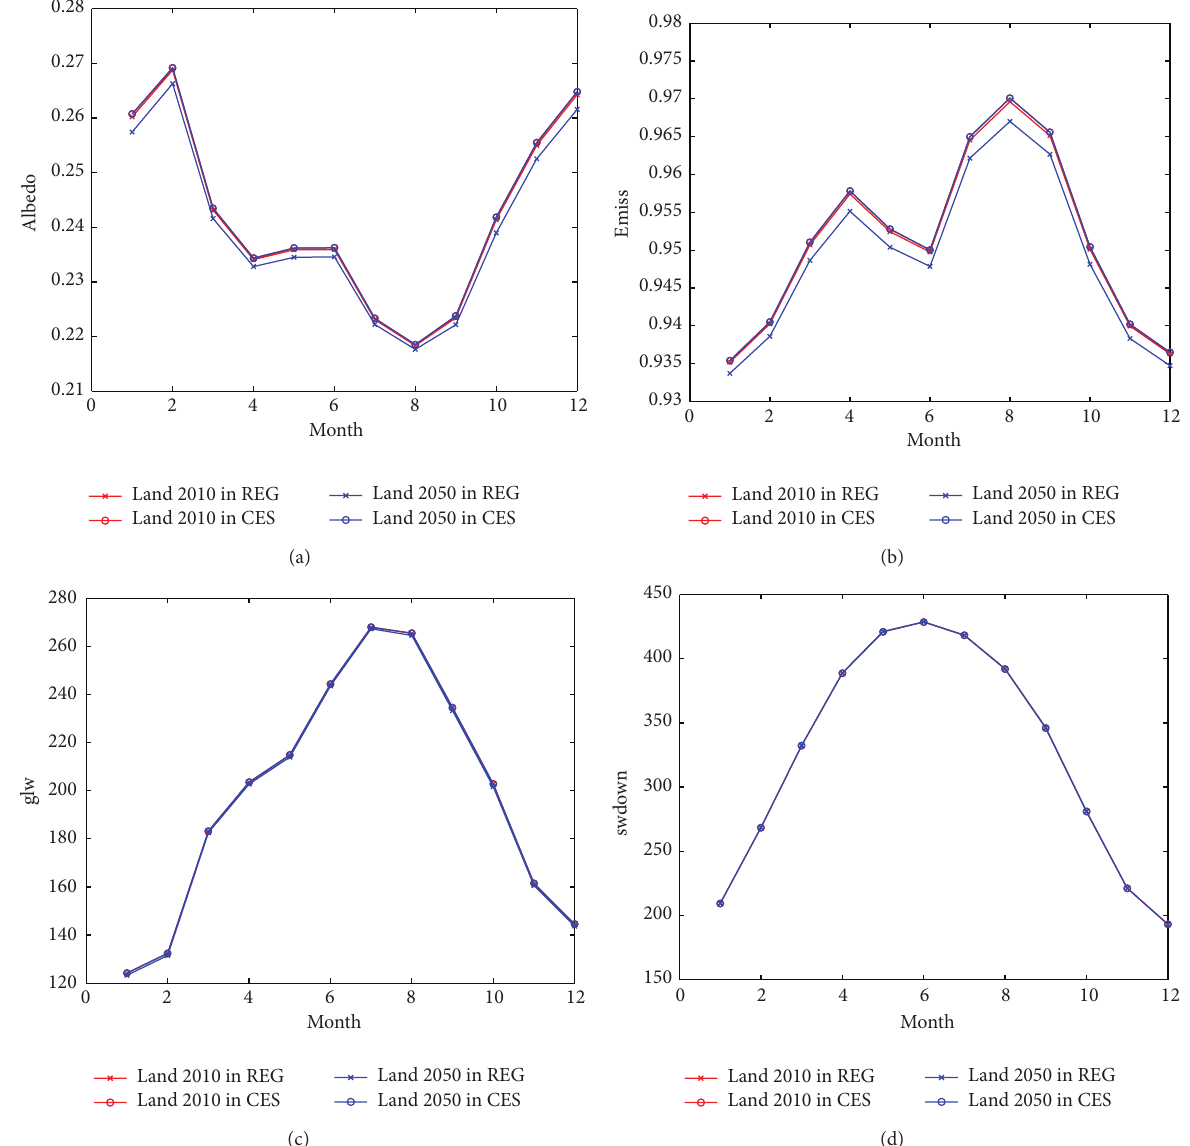
Figure 8: Influence of the future land use change on the key biogeophysical parameters in Southern-Jiangsu. (a) and (b) show the influence of the future land use change on albedo and surface emissivity; (c) and (d) show the influence of the future land use change on downward long-wave radiation and downward shortwave radiation (W/m 2